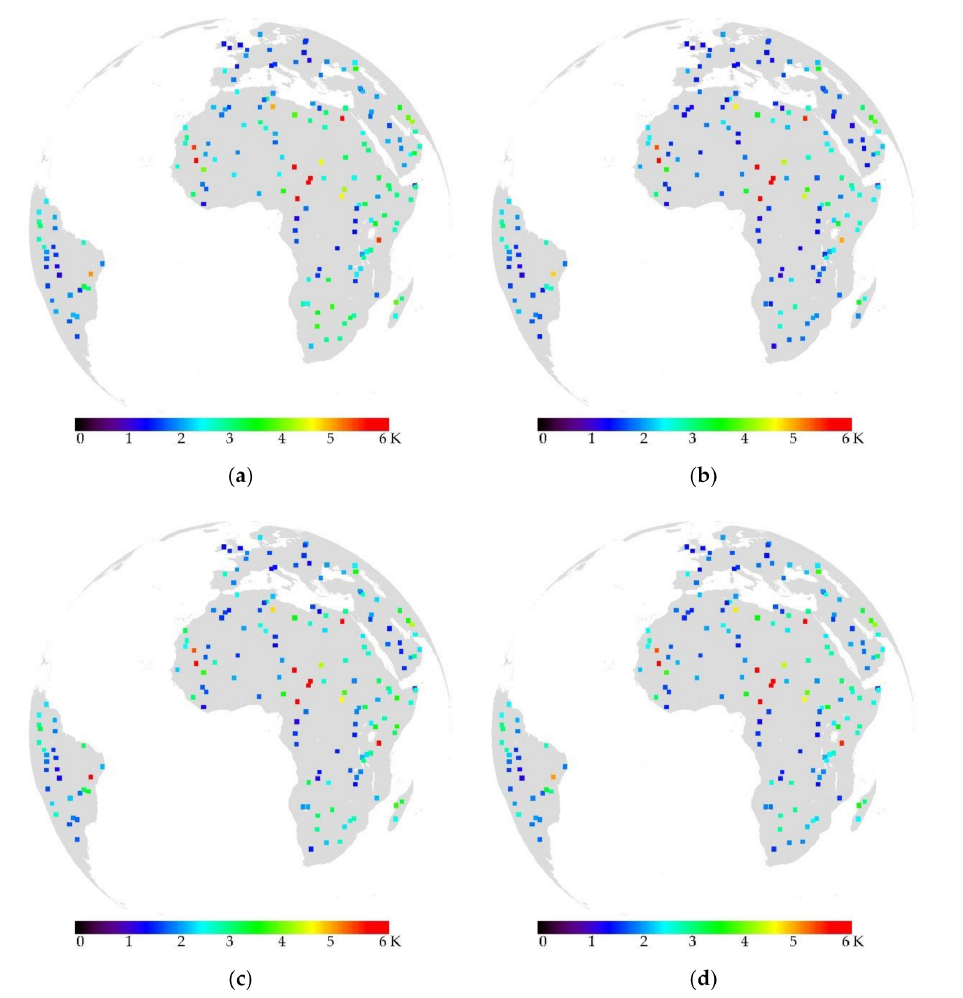
Figure 5. Standard deviation values averaged over each BELMANIP site for the drifted time series ( a ) and the corrected time series C0, C1, and C2 ( b , c , and d ,